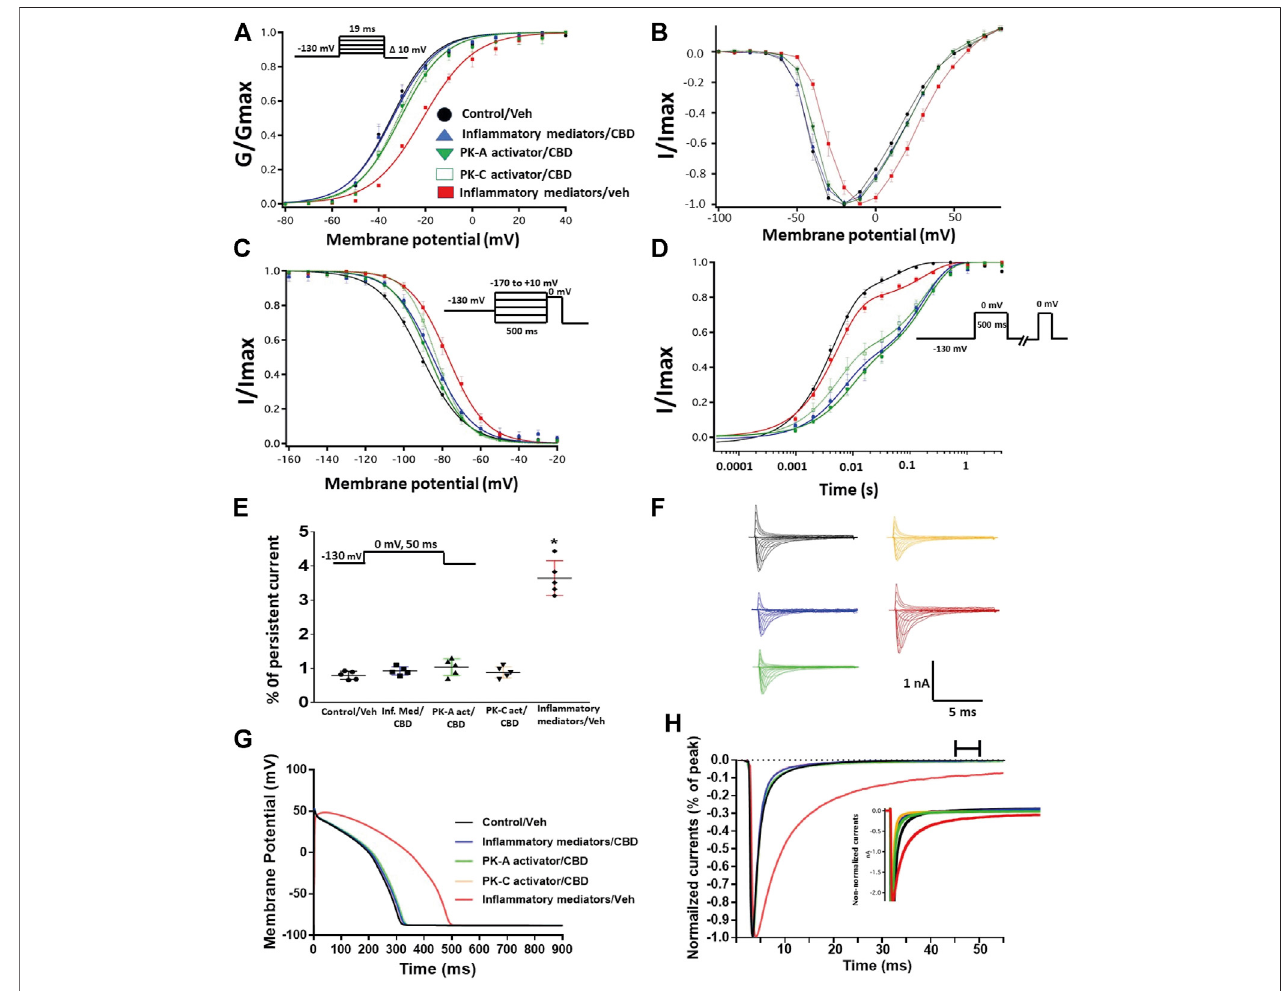
FIGURE 4 | (A) Effect of CBD (5 μ M, perfusion) on the conductance curve of Nav1.5 transfected CHO cells incubated with in fl ammatory mediators (24 h) or PK-A activator (CPT-cAMP; 1 μ M, for 20 min) or PK-C activator (PMA; 10 nM, for 20 min) with the insert showing the protocol ( n (cid:2) 5, each). (B) IV curves (C) Effect of CBD (5 μ M, perfusion) on SSFI of Nav1.5 transfected CHO cells incubated with in fl ammatory mediators (24 h) or PK-A activator (CPT-cAMP; 1 μ M, for 20 min) or PK-C activator(PMA;10 nM,for20 min)withtheinsertshowingtheprotocol( n (cid:2) 5,each). (D) EffectofCBD(5 μ M,perfusion)onrecoveryfromfastinactivationofNav1.5 transfectedCHOcellsincubatedwithin fl ammatorymediators(24 h)orPK-Aactivator(CPT-cAMP;1 μ M,for20 min)orPK-Cactivator(PMA;10 nM,for20 min)withthe insertshowingtheprotocol( n (cid:2) 5,each). (E) EffectofCBD(5 μ M,perfusion)onthepercentage ofpersistentsodiumcurrentsofNav1.5transfectedCHOcellsincubated within fl ammatory mediators(24 h)orPK-A activator (CPT-cAMP; 1 μ M,for 20 min)orPK-C activator (PMA; 10 nM,for 20 min)withtheinsert showing theprotocol(n (cid:2) 5,each). (F) Representativefamiliesofmacroscopiccurrents. (G) EffectofCBD(5 μ M,perfusion)onthe Insilico actionpotentialdurationofNav1.5transfectedCHOcells incubated in in fl ammatory mediators (24 h) or PK-A activator (CPT-cAMP; 1 μ M, for 20 min) or PK-C activator (PMA; 10 nM, for 20 min). (H) Representative persistent currents across conditions. Currents were normalized to peak current amplitude. Bar above current traces indicates period during which persistent current was measured. Inset shows non-normalized currents. * p < 0.05 vs. corresponding “ Control/Veh ” values using one-way ANOVA along with post hoc testing.